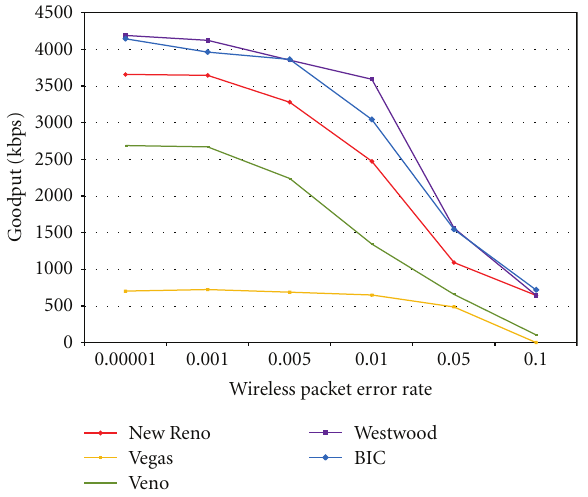
Figure 16: Goodput versus queue size of the bottleneck link in WiFi for the second scenario (PER = 10 − 5